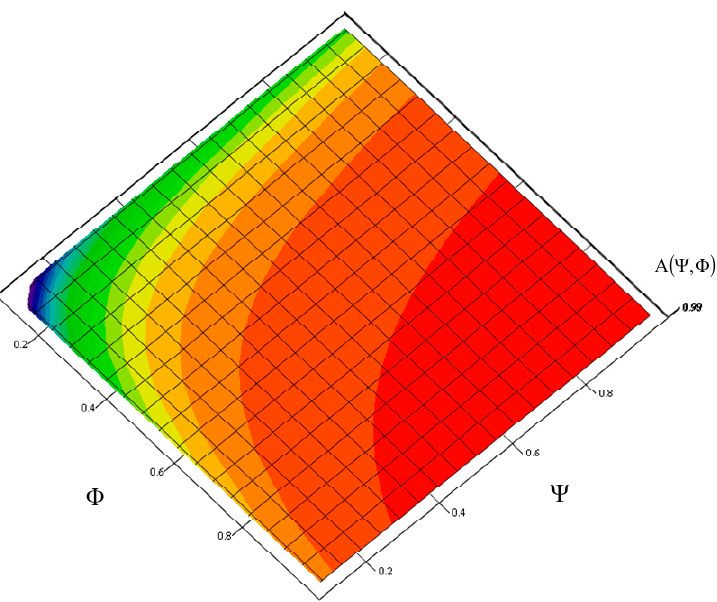
Figure 4. Graph showing the impact of a toll collection station replaceable module demand index and the index on expenditure on replaceable modules, on the value of its readiness index. Source: own study. Table 3. List of impact values of a toll collection station replaceable module demand index and the index on expenditure on replaceable modules on the value of its readiness index. Source: own study based on [14].